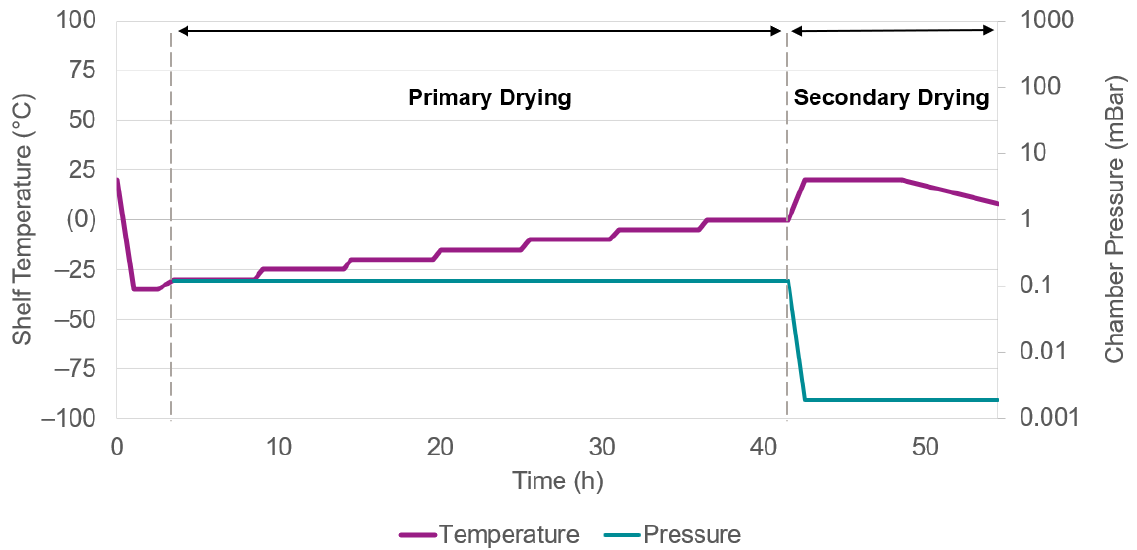
Figure 2. Freeze-drying protocol of the PLGA-based nanoparticles.